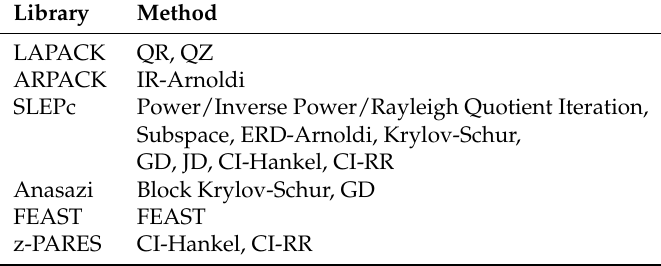
Table 3. Methods of open-source libraries for non-symmetric eigenvalue